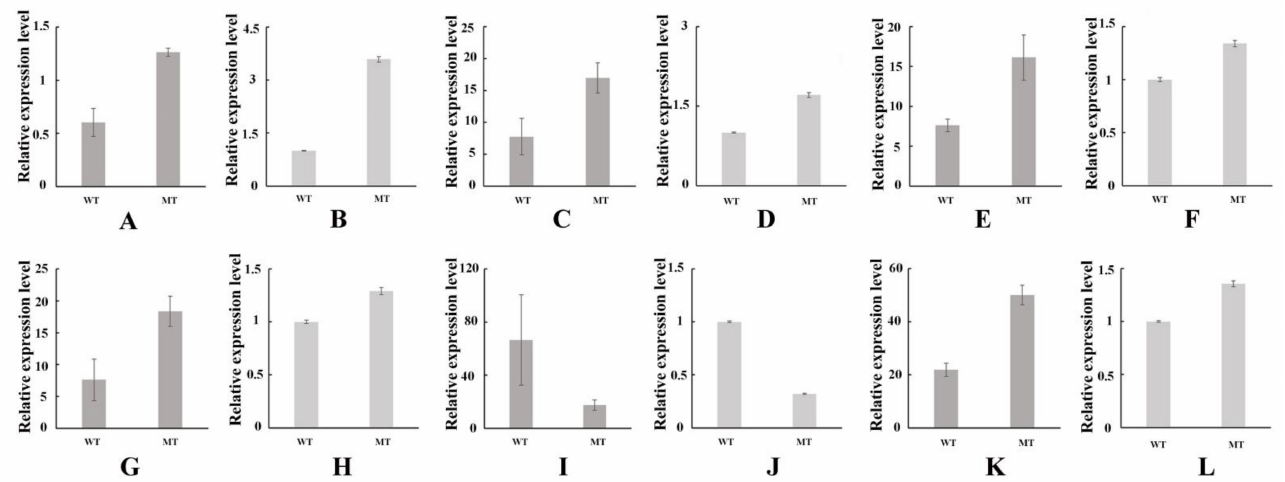
Figure 5. qRT-PCR confirmation of the DEGs identified by the transcriptome analysis. The relative expression level of each gene was expressed as the fold-change relative to the internal reference gene cyclophilin. WT means wild type; MT means yellowleaf mutant type; ( A , B ), unigene ID: Cluster-41647.30461. The relative expression of chlL . ( C , D ), unigene ID: Cluster-41647.18465. The relative expression of hemE . ( E , F ), unigene ID: Cluster-41647.32963. The relative expression of EARS . ( G , H ), unigene ID: Cluster-41647.29473. The relative expression of VDE . ( I , J ), unigene ID: Cluster- 41647.15332. The relative expression of petH . ( K , L ), unigene ID: Cluster-41647.24000. The relative expression of psbA . ( A , C , E , G , I , K ), the data of RNA-Seq. ( B , D , F , H , J , L ), the data of qRT-PCR. The qPCR data of each sample with three biological and three technical